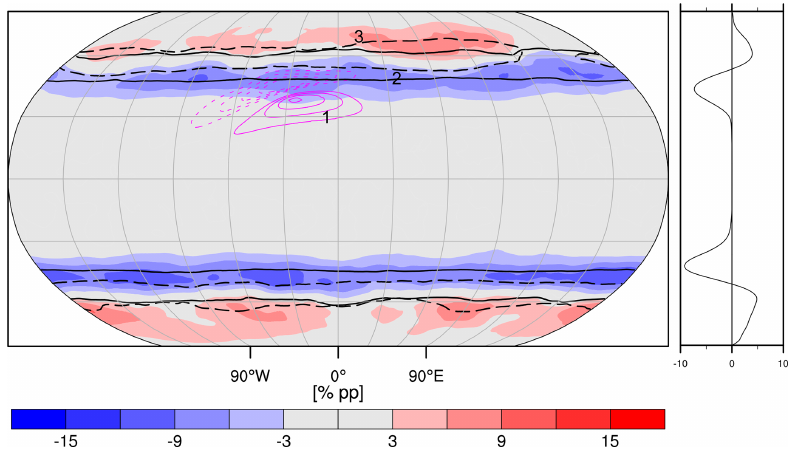
Figure 7. Change in surface cyclone frequencies (shading; percentage points) between warmed and control simulations. Additional black contours indicate absolute cyclone frequency of 20% (dashed for the warmed simulation and solid for the control; as in the previous figures, the SST front is indicated by purple contours). Labels from Fig. 2 are